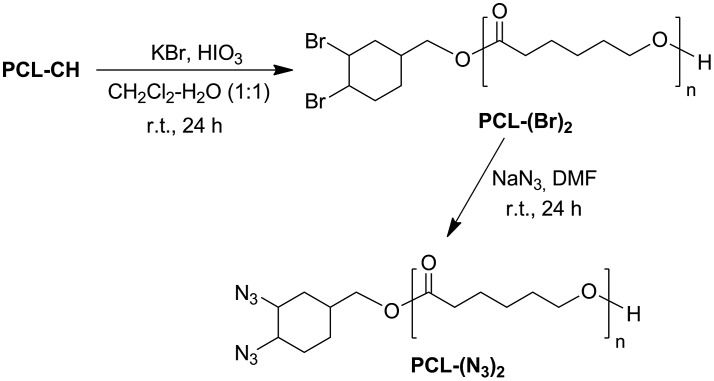
Synthetic procedures for PCL-(Br)2 and PCL-(N3)2.